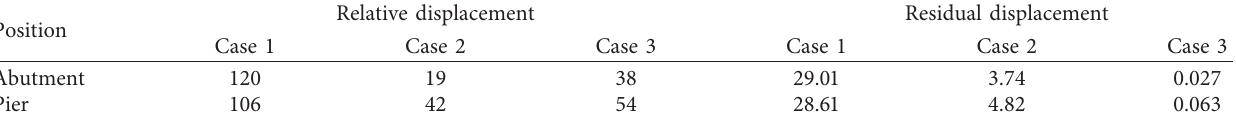
Table 7: The relative displacement and residual displacement between pier and girder under different analysis cases (mm). Position